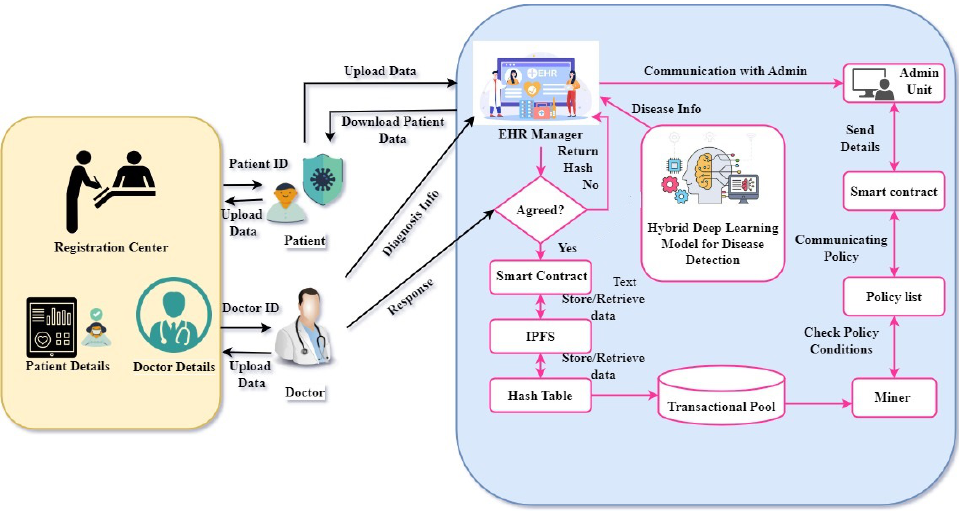
Figure 1. The proposed model of blockchain-based healthcare